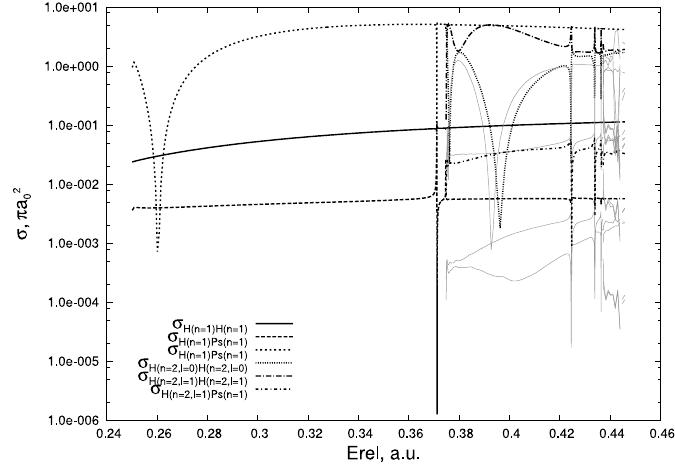
Figure 7. Energy dependence of the cross sections for several allowed processes in the positron-Hydrogen system. Several channels are left unmarked for simplicity. E rel is the energy of the system measured relative to the ground state of